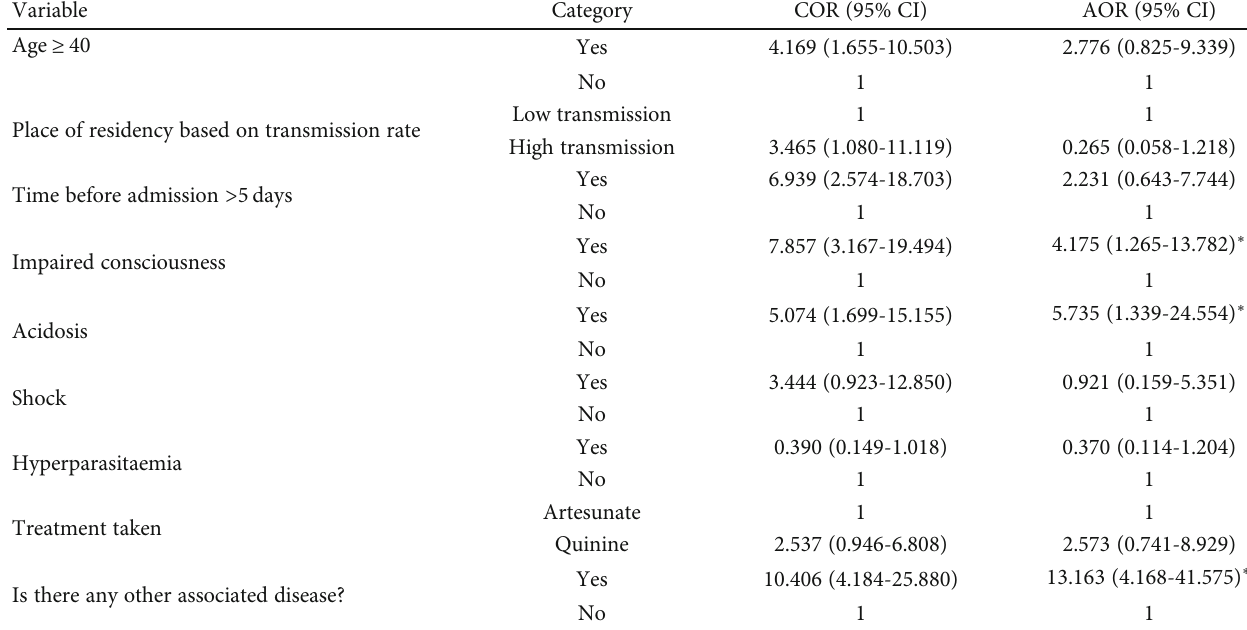
Table 6: Death risk factor associated with severe malaria among adults admitted in Arba Minch General Hospital from September 2015 to August 2018, n = 387